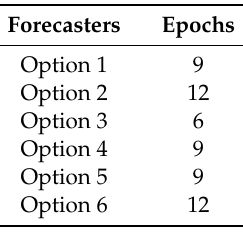
Table 11. Epochs number for each